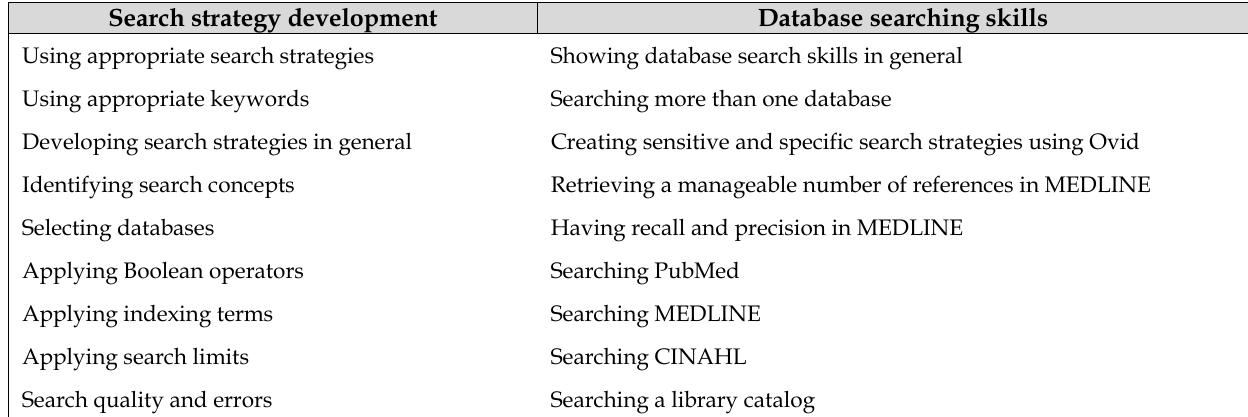
Table 2 Outcomes clustered in two categories: (1) search strategy development and (2) database search skills Search strategy